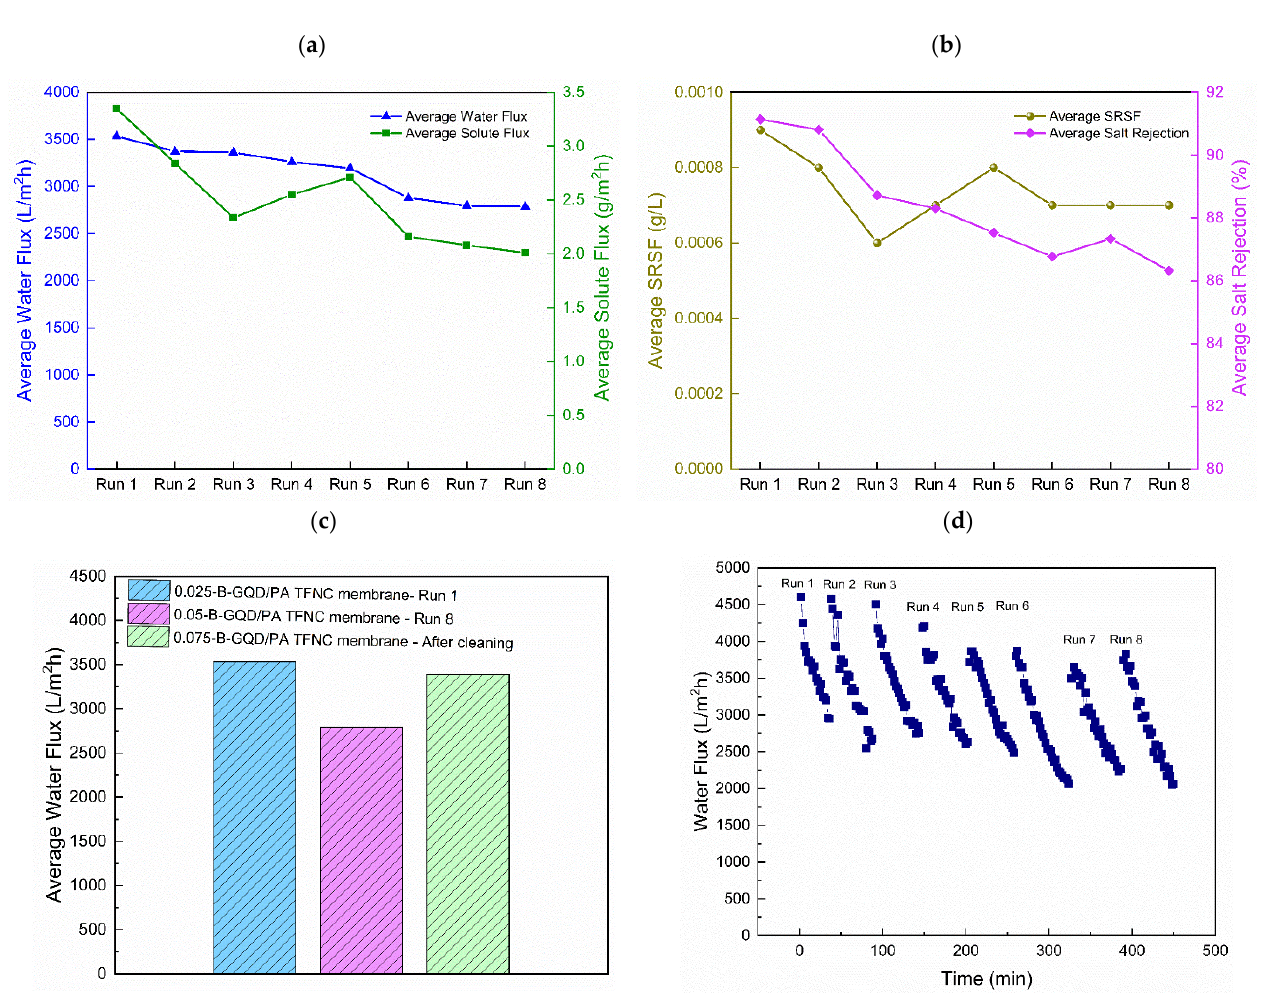
Figure 11. ( a ) Average water flux and average solute flux of the 0.05-B-GQD/PA TFNC membrane in a long-period performance assessment study; ( b ) average specific reverse solute flux (g/l) and salt rejection (%) of the 0.05-B-GQD/PA TFNC membrane in a long-period performance assessment study; ( c ) cleaning effectiveness of the 0.05-B-GQD/PA TFNC membrane after long-period FO experiments; ( d ) water flux (L/m 2 h) of the 0.050-GQD/PA TFNC membranes in long-period performance analysis—eight runs.